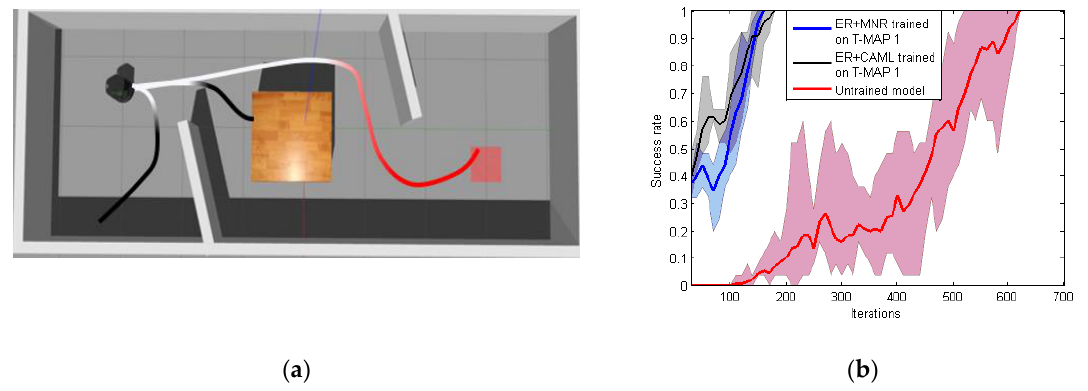
Figure 13. ( a ) Output value produced by MN in GT-MAP 2 and ( b ) training results.